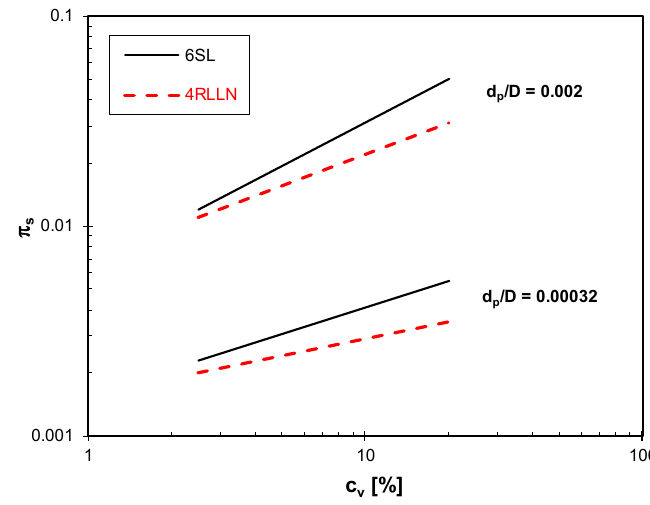
Figure 14. Comparison of the dimensionless power required to achieve the just-suspended state of particles for a standard pitched blade impeller and an axial flow impeller with large area folded blades [11,22].